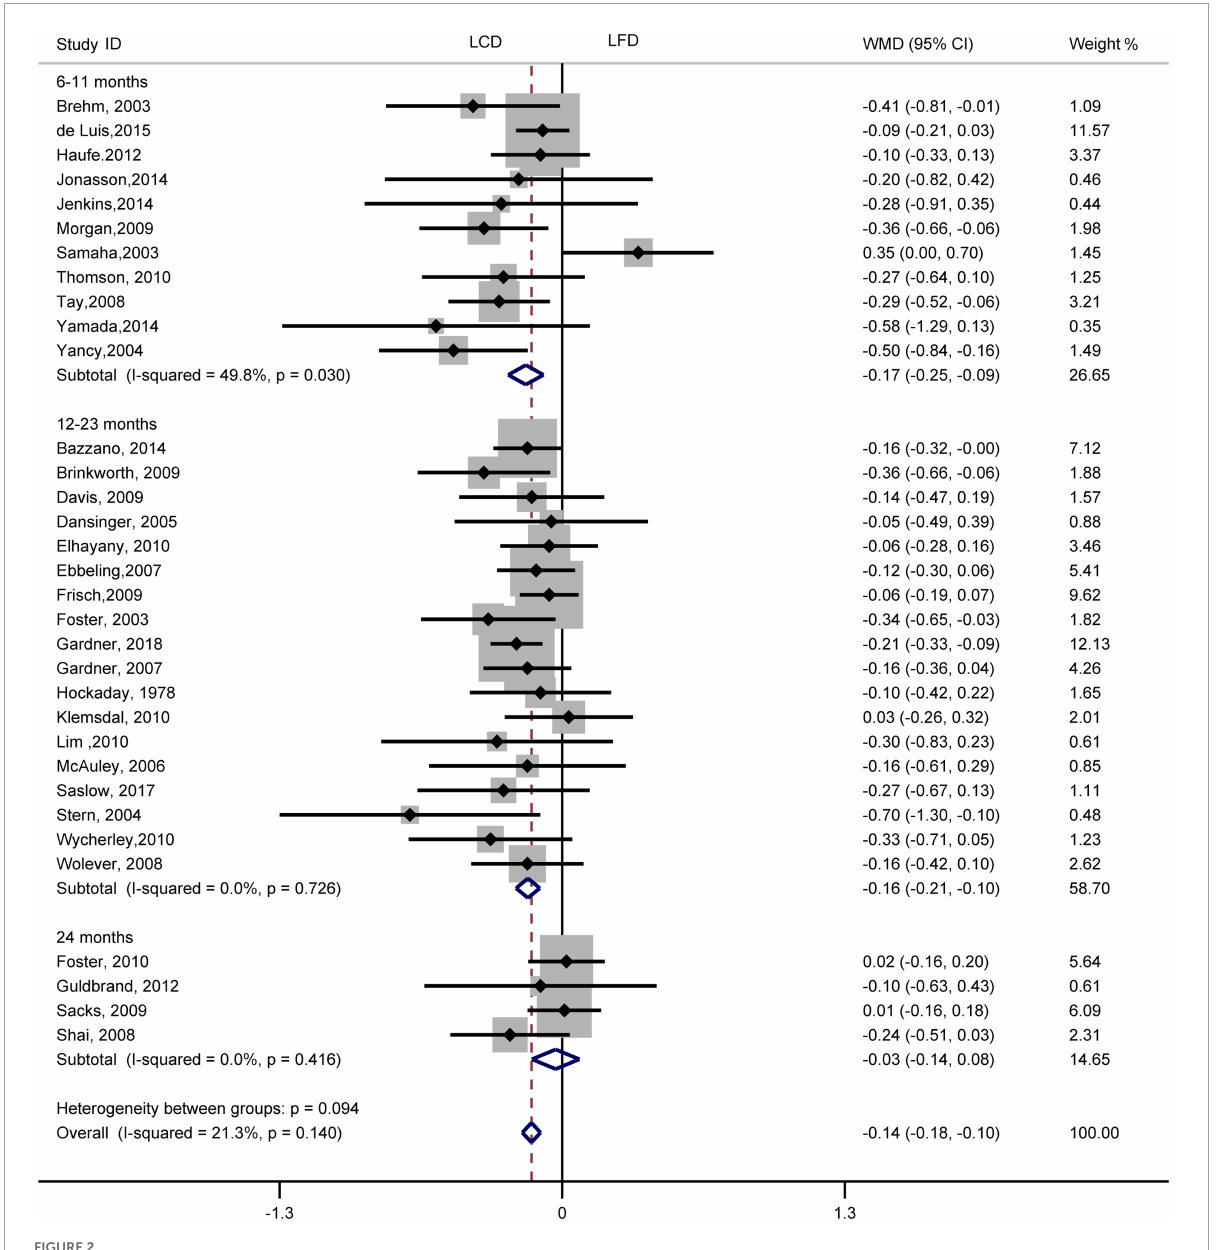
FIGURE2 Forest plots showing weight mean differences (WMD) and 95% CI for triglyceride of the low-carbohydrate diets (LCD) in comparison with low-fat diets